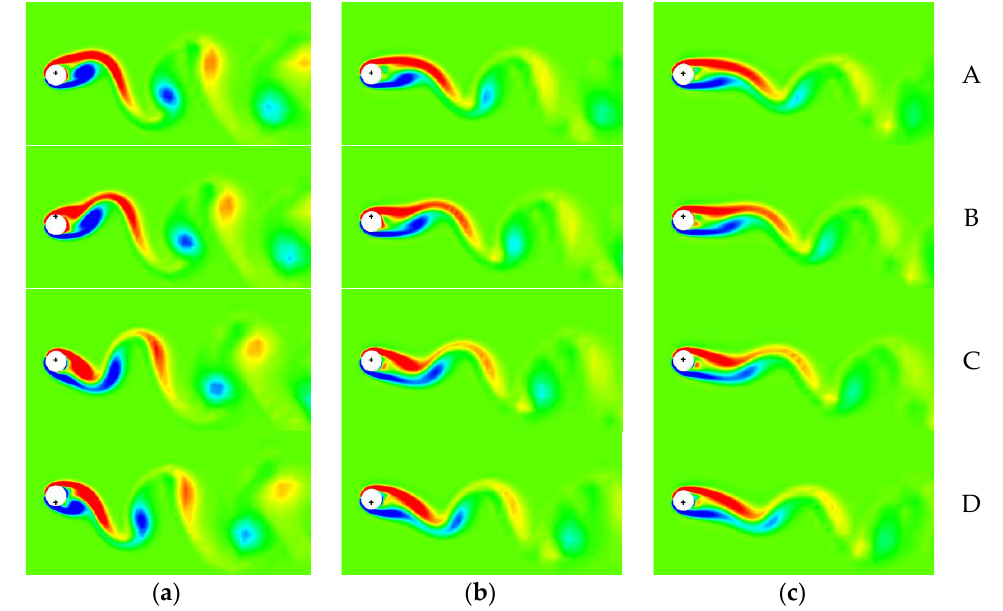
Figure 6. Vorticity evolutions of VIV with different values of interaction parameter N for shear rate K = 0.2 where A, B, C and D represent the times at t = 0T/4, 1T/4, 2T/4 and 3T/4, respectively: ( a ) N = 0; ( b ) N = 0.8; and ( c ) N = 1.3.